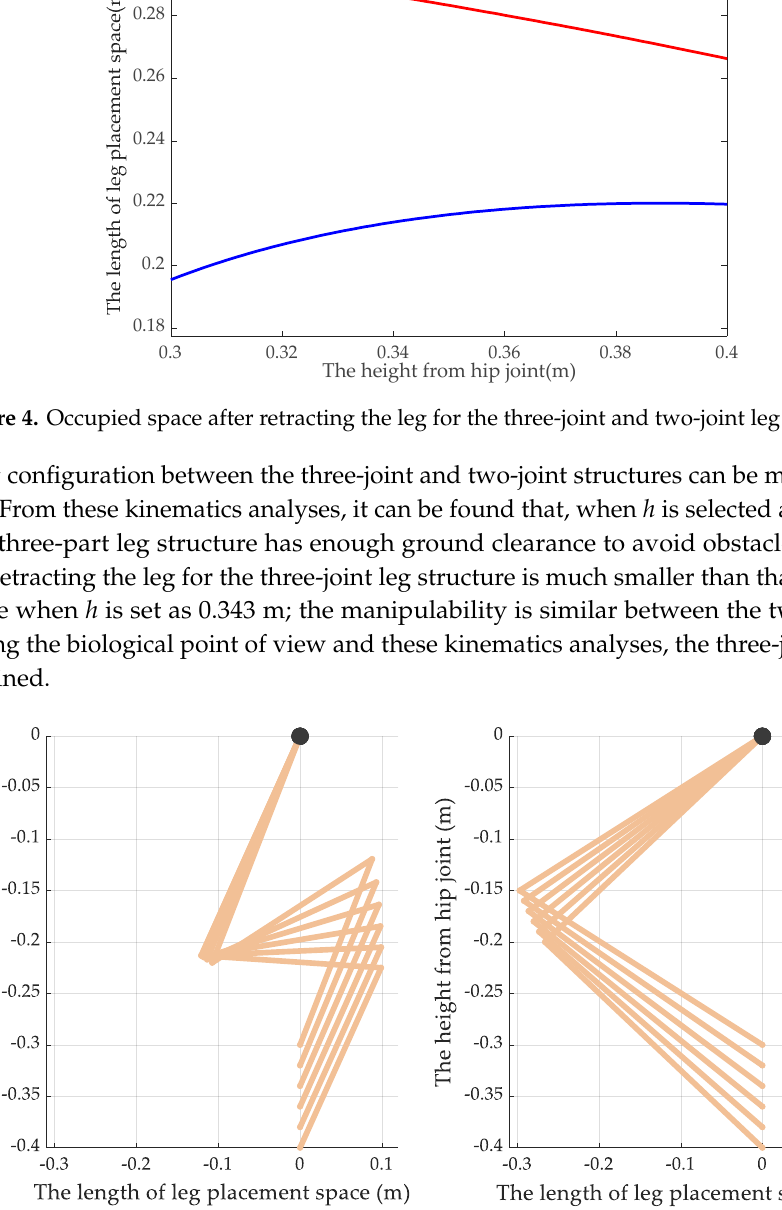
Figure 5. Leg configuration comparisons between the three-joint and two-joint leg structures.